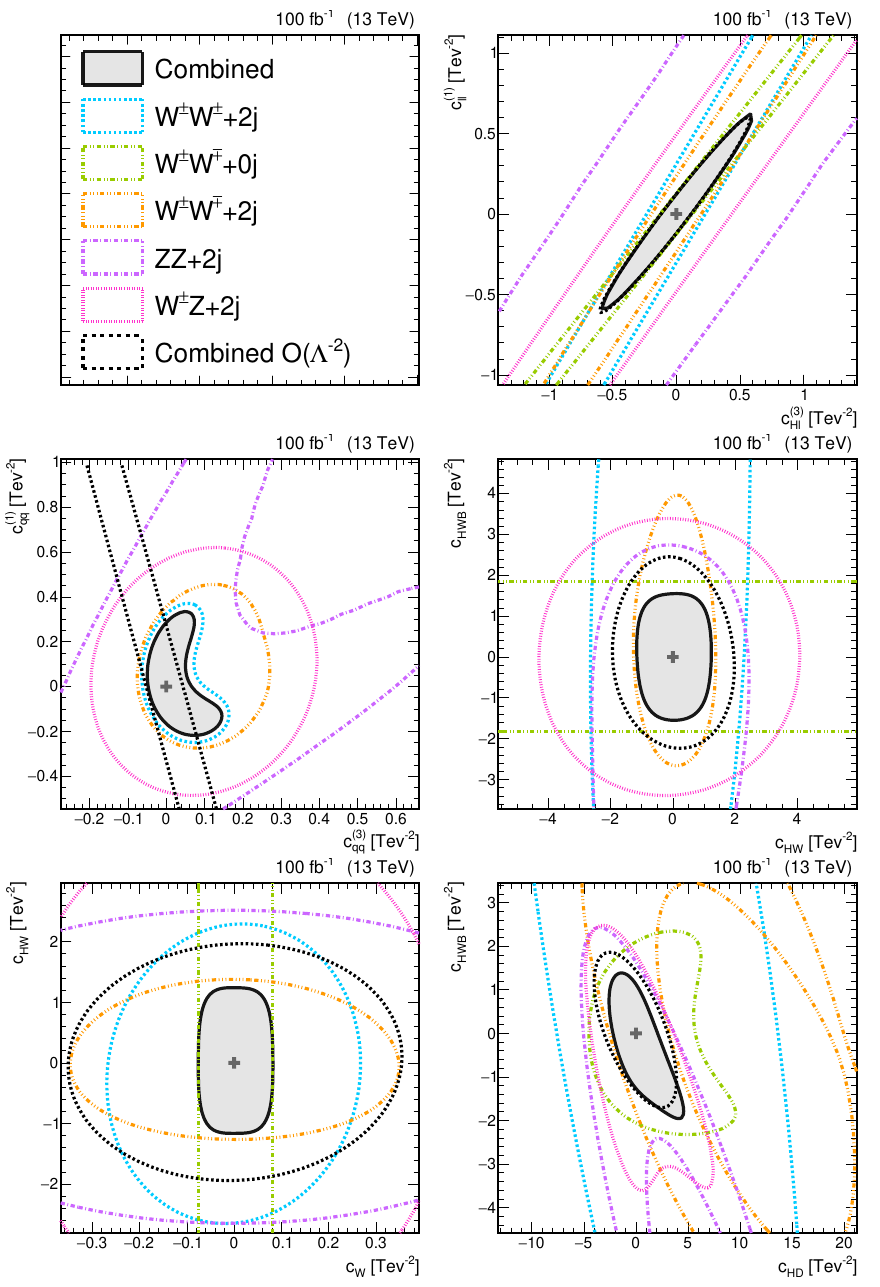
Figure 8 . Bi-dimensional likelihood contours for − 2∆ log L = 2 . 3 (68%c.l.), for individual channels (in color) and for their combination (black). The VBS W + W − + 2 j , W ± Z + 2 j , ZZ + 2 j channels include the respective QCD-induced processes. Only two Wilson coefficients are varied at a time, while the others are fixed to zero. Quadratic EFT contributions are included in all baseline cases. For comparison, the black dashed line shows the contour for the combined likelihood obtained truncating the EFT parametrization at the linear